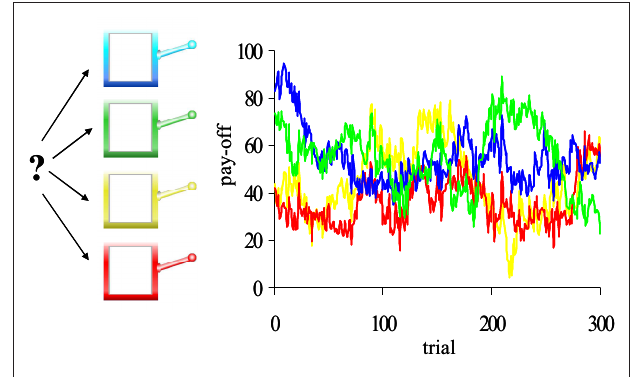
Figure 2 | The four-armed bandit task. Participants made repeated choices between four slot machines. Unlike standard slots, the mean pay-offs of the four machines changed gradually and independently from trial to trial (four colored lines). Participants were encouraged to earn as many points as possible during the task. Each choice was classified as exploitative or exploratory, using a computational model of reinforcement